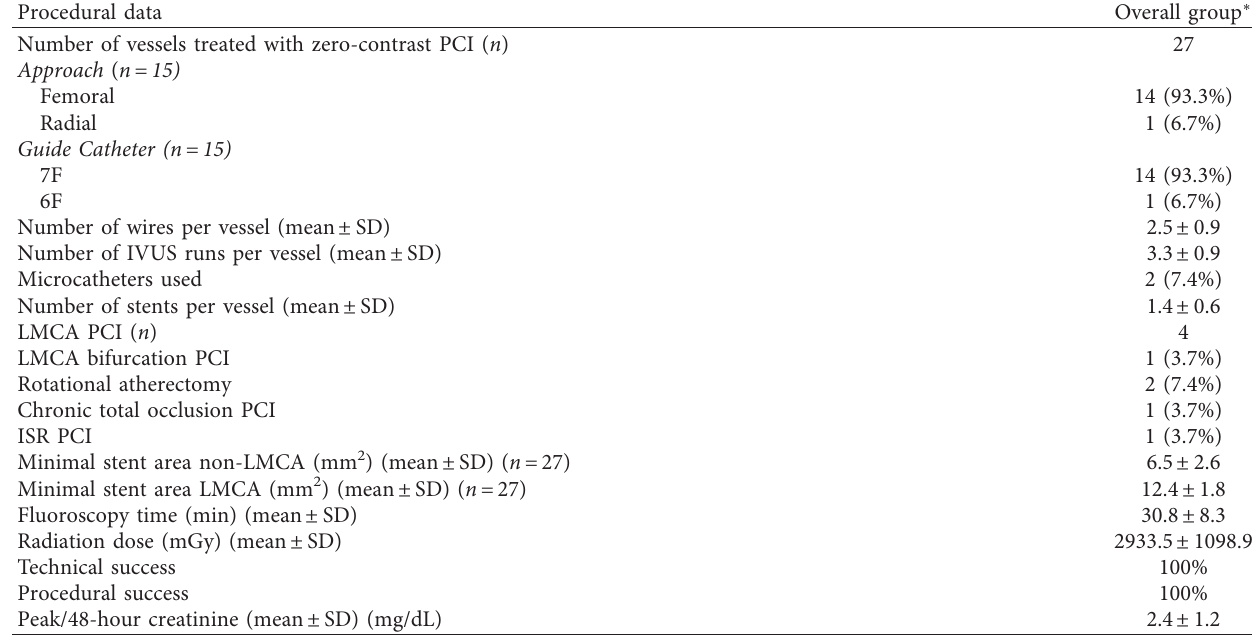
Table 3: Procedural